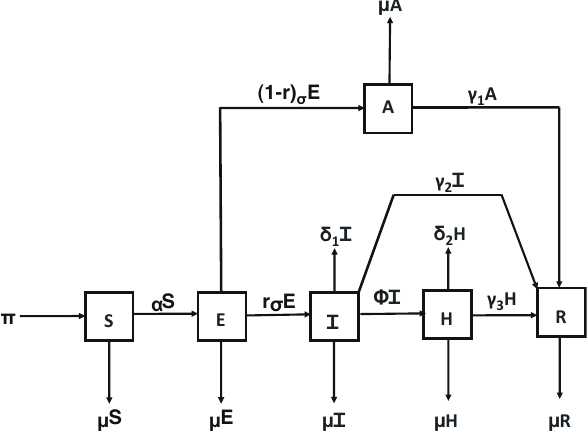
Figure 1: The schematic diagram for the model ( 1 )